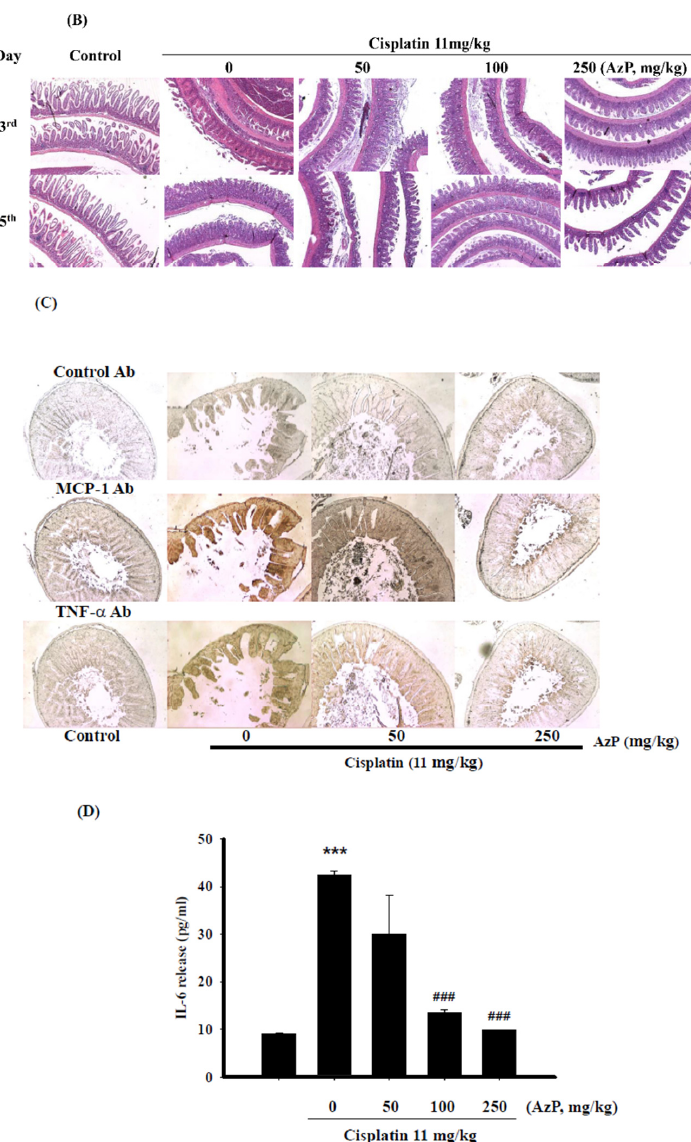
Figure 2. Efficacy of AzP in cisplatin-induced mucositis model of C57BL/6. ( A ) Weights recorded from C57BL/6 mice treated with 11 mg/kg cisplatin only with gavage of hydroxypropyl- β -cyclodextrin (HP β CD) and 50, 100, and 250 mg/kg/day AzP from days − 1 to 9 are shown. The changes in weight were analyzed by calculation of the percentage of change from baseline. Relative body weight change (%) is shown with the data expressed as mean ± standard deviation (SD).; ( B ) The intestinal mucosa of C57BL/6 mice experienced thinning, a consequence of cisplatin chemotherapy. Mice pretreated with AzP for 3 days had thickened mucosa relative to chemotherapy-treated controls. This was the result of longer villi and deeper crypts; however, a similarity to normal control from the swiss-roll trimming on days 3 and 5 was observed. Images are at 40× magnification; ( C ) Effect of AzP on cisplatin-induced inflammatory protein expression in jejunum from C57BL/6 mice on day 5. Mice received AzP dosages of 0, 50, and 250 mg/kg, 30 min before i.p. injection with 11 mg/kg cisplatin to induce mucositis. After 120 h of stimulation, jejunum sections were analyzed using the immunohistochemistry (IHC) method. Images are at 100× magnification; ( D ) Serum IL-6 level was detected on day 5. Data expressed as mean ± SD. *** p < 0.001 compared with control and ### p < 0.001 compared with AzP-treated group.